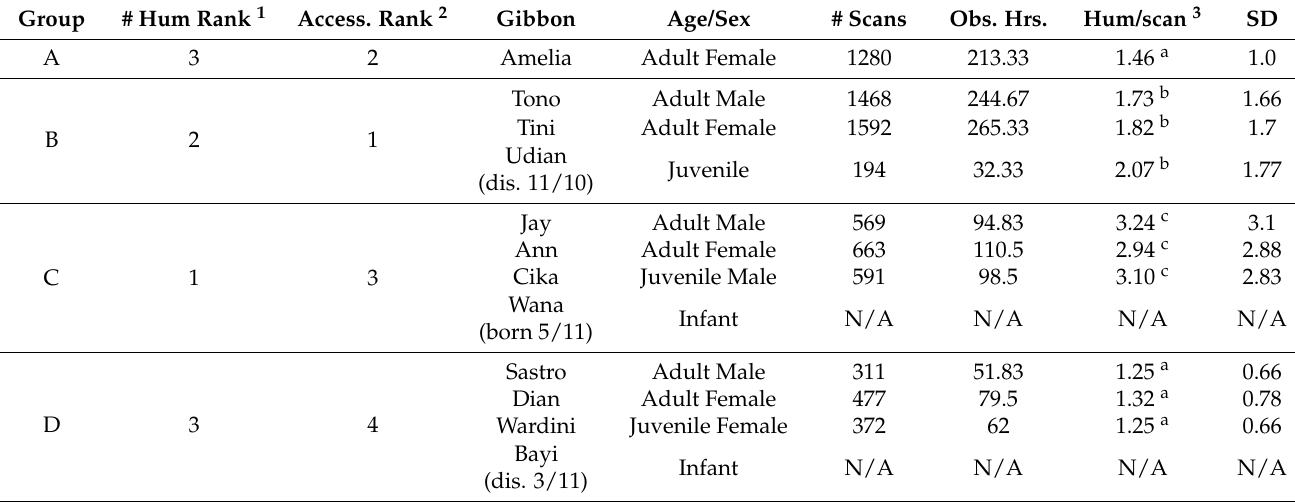
Table 1. Gibbons in Sancang